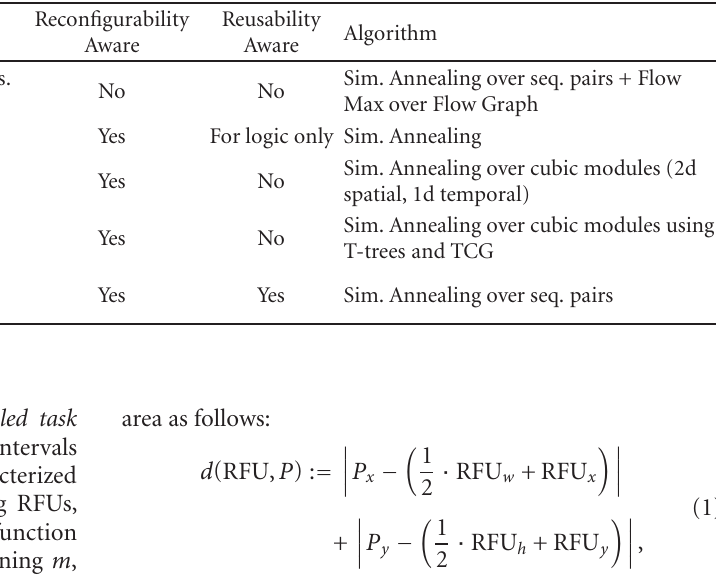
Table 1: Comparison among previous